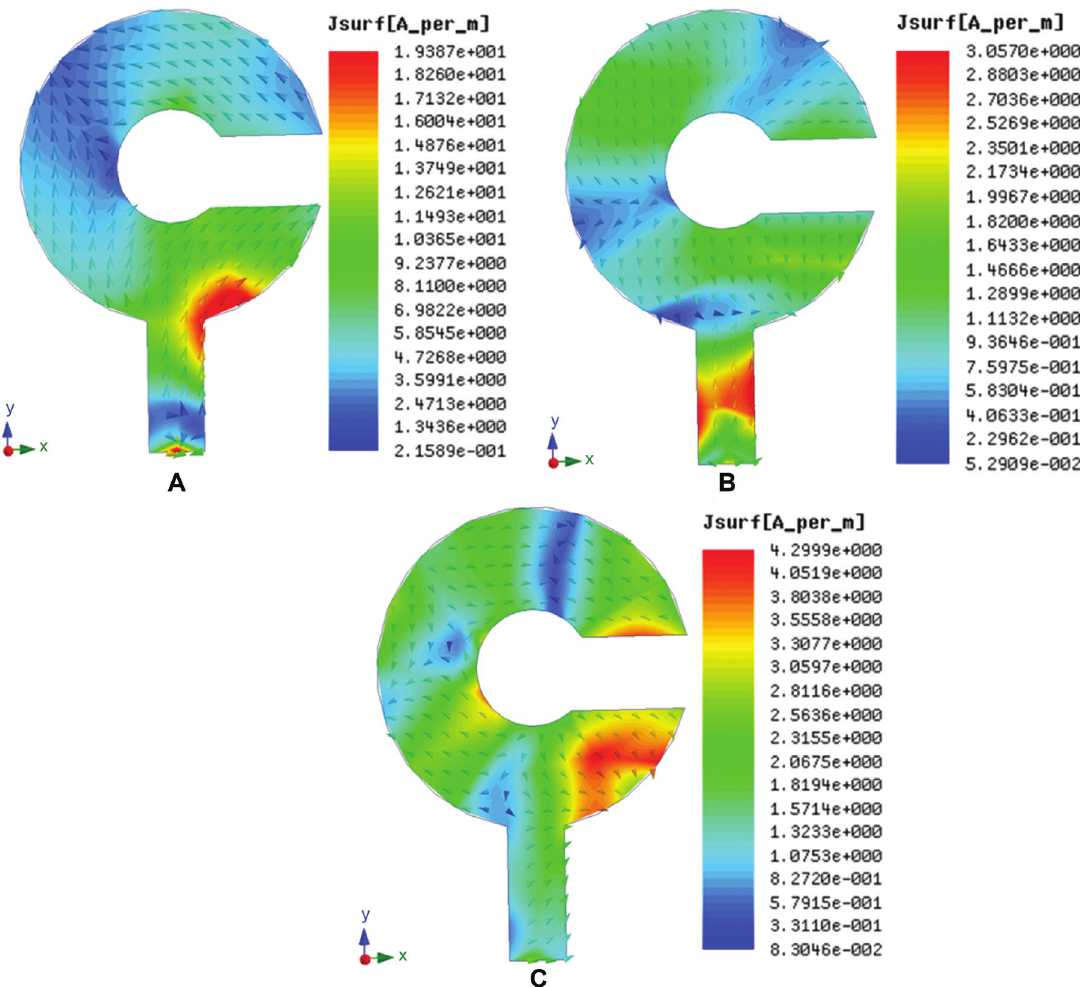
Figure 9 Simulated surface current distribution of the proposed antenna at (A) 5.6 GHz, (B) 9.5 GHz, and (C) 10.9 GHz.